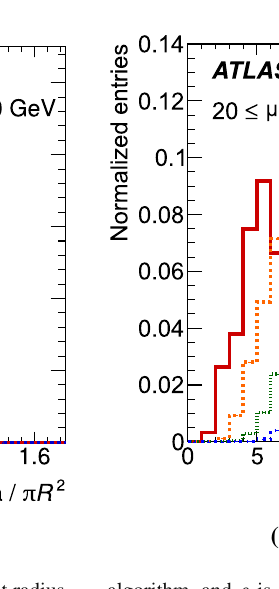
algorithm, and ρ is shown for different numbers of reconstructed pri- mary vertices N PV in events with average number of pp interactions in the range 20 ≤ μ <